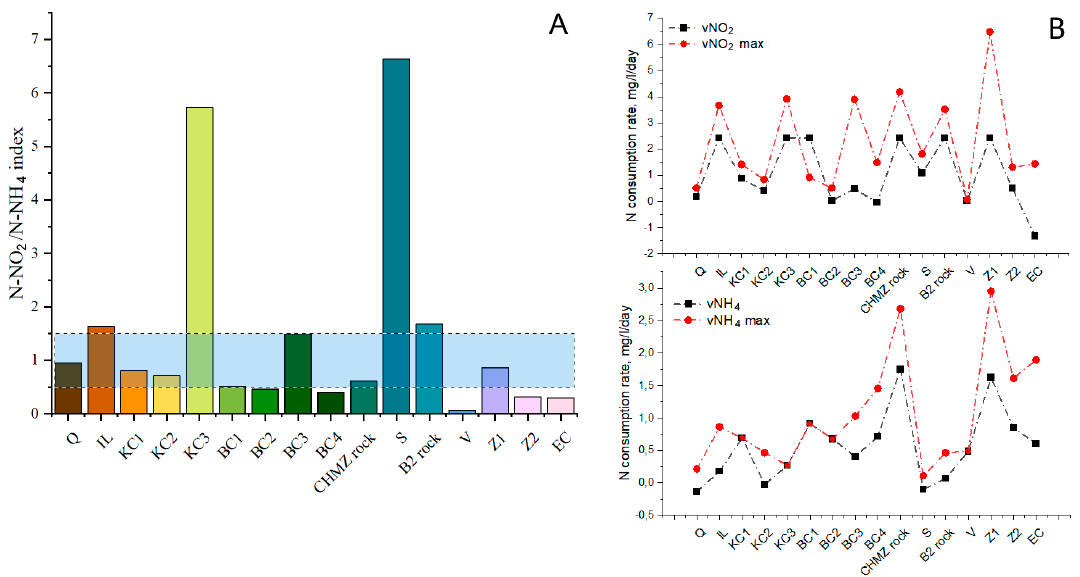
Figure 5. The ratio of consumed ammonium and nitrite nitrogen (N-NO 2 /N-NH 4 ) ( A ) and ammo- nium and nitrite uptake rates ( B ) on mineral carriers by the indigenous microbial community.